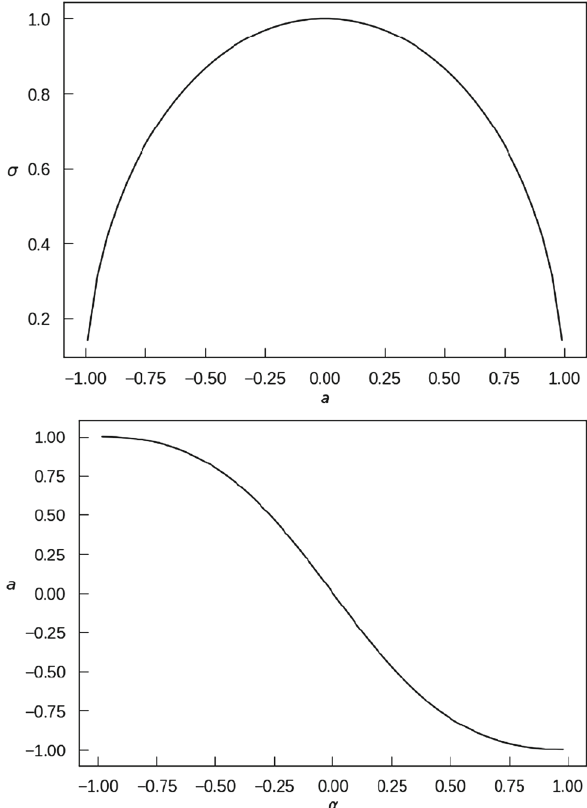
Fig. 1 The rotation parameter a as a function of the parameters σ and α with m = 1